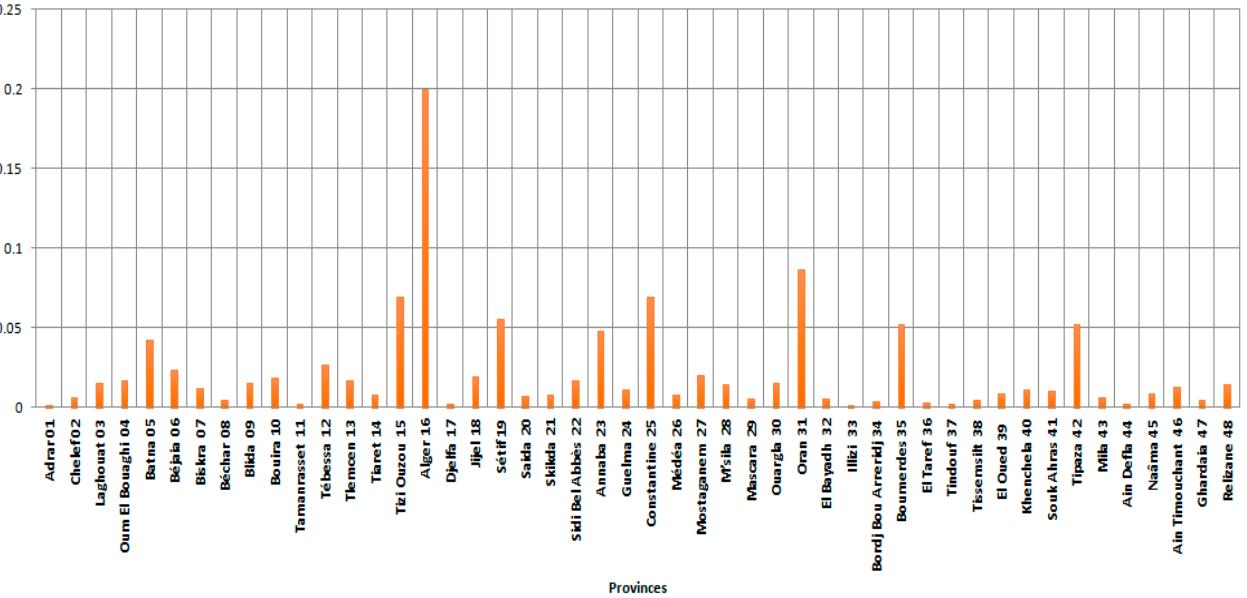
Figure 10. Radar plot of Morbidity rates in the provinces (48 provinces) by COVID ‐ 19 between 1 January 2021 and 15 August 2021. Table 2 presented the COVID ‐ 19 infection rates in the country, where we used OpenBUGS with 30,000 iterations in order to use Equation (8) on a large amount of data. Table 2 showed that the provinces of the Sahara are the least affected by COVID ‐ 19. Moreover, the risk of infection in Algiers province was twice higher than in Oran prov ‐ ince. This observation, together with the mortality rate, indicated a mutual risk of mortal ‐ ity and infection in this province.